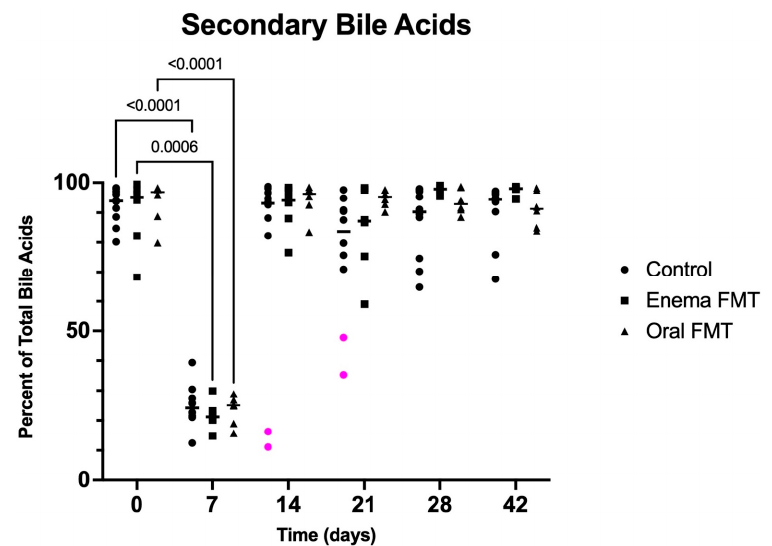
Figure 5. Dot plot graph representing the percentage of secondary fecal UBA in control dogs, dogs receiving FMT by enema, and dogs receiving FMT orally over the 6-week duration of the study. Legend: Dots represent individual values for each dog, bars denote medians for the group and time point. Statistically significant pairwise comparisons are shown. The magenta dots identify 2 dogs with low percentual secondary fecal bile acid concentrations at day 14 that also had very low fecal abundances of C. hiranonis at that same time (see Figure 3). Percentual secondary bile acid concentrations were also low at day 21 in these 2 dogs.